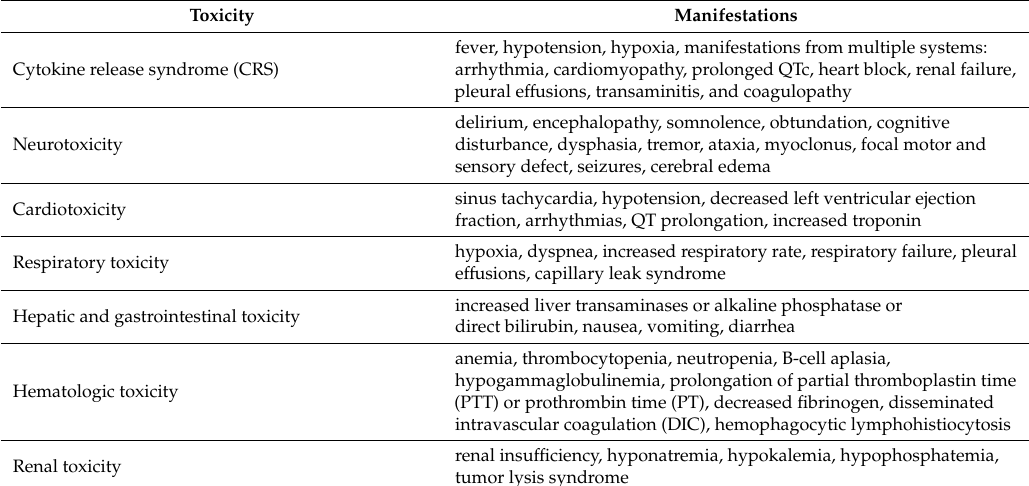
Table 1. Clinical manifestations of CAR-T cells